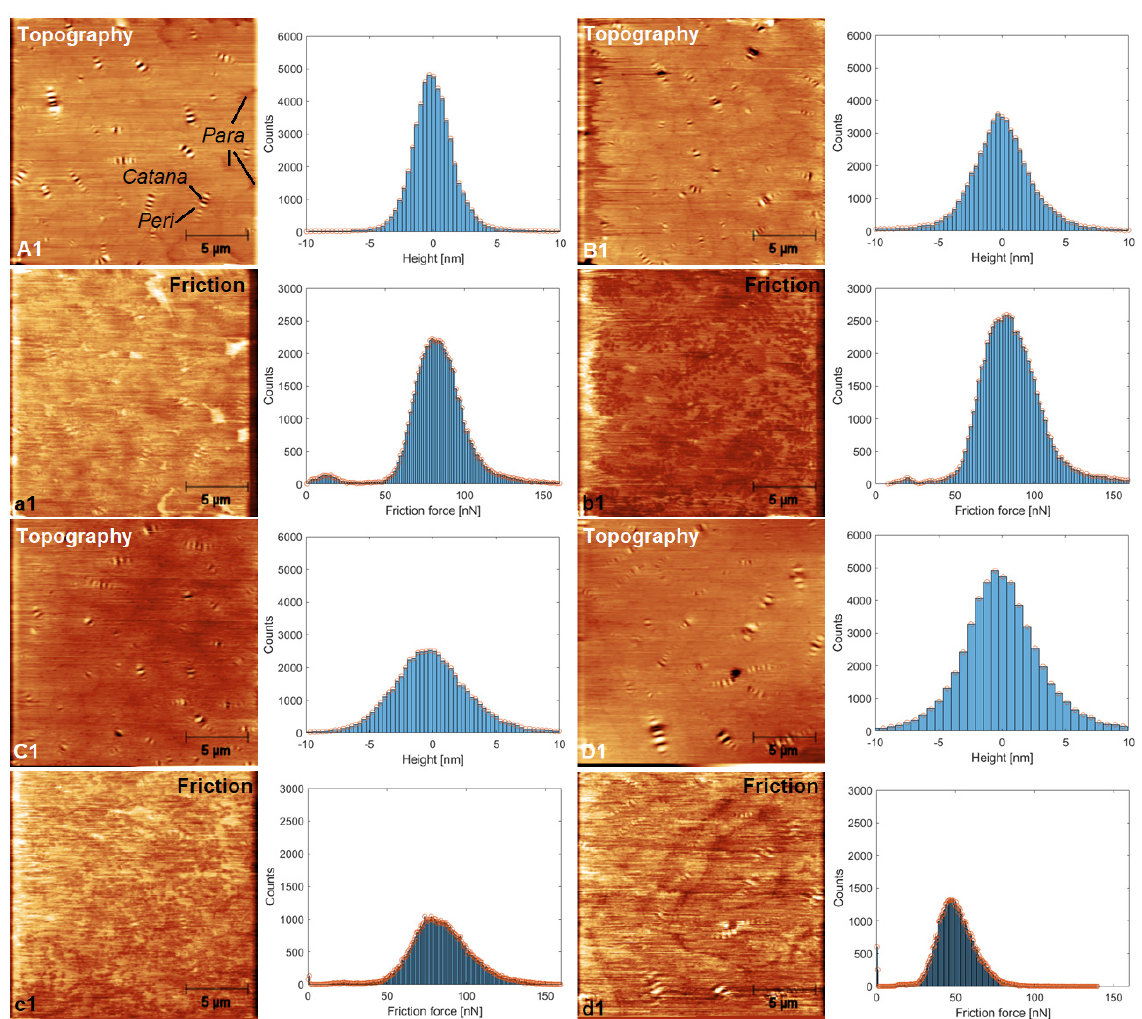
Figure 6. AFM topography and friction images with their corresponding histograms on the right side highlighting the influence of DCG on base AP-5 asphalt micromorphology and friction. ( A1 , a1 ) AP-5 DCG 0 wt%; ( B1 , b1 ) AP-5 DCG 1 wt%; ( C1 , c1 ) AP-5 DCG 2 wt%; ( D1 , d1 ) AP-5 DCG 3 wt%.